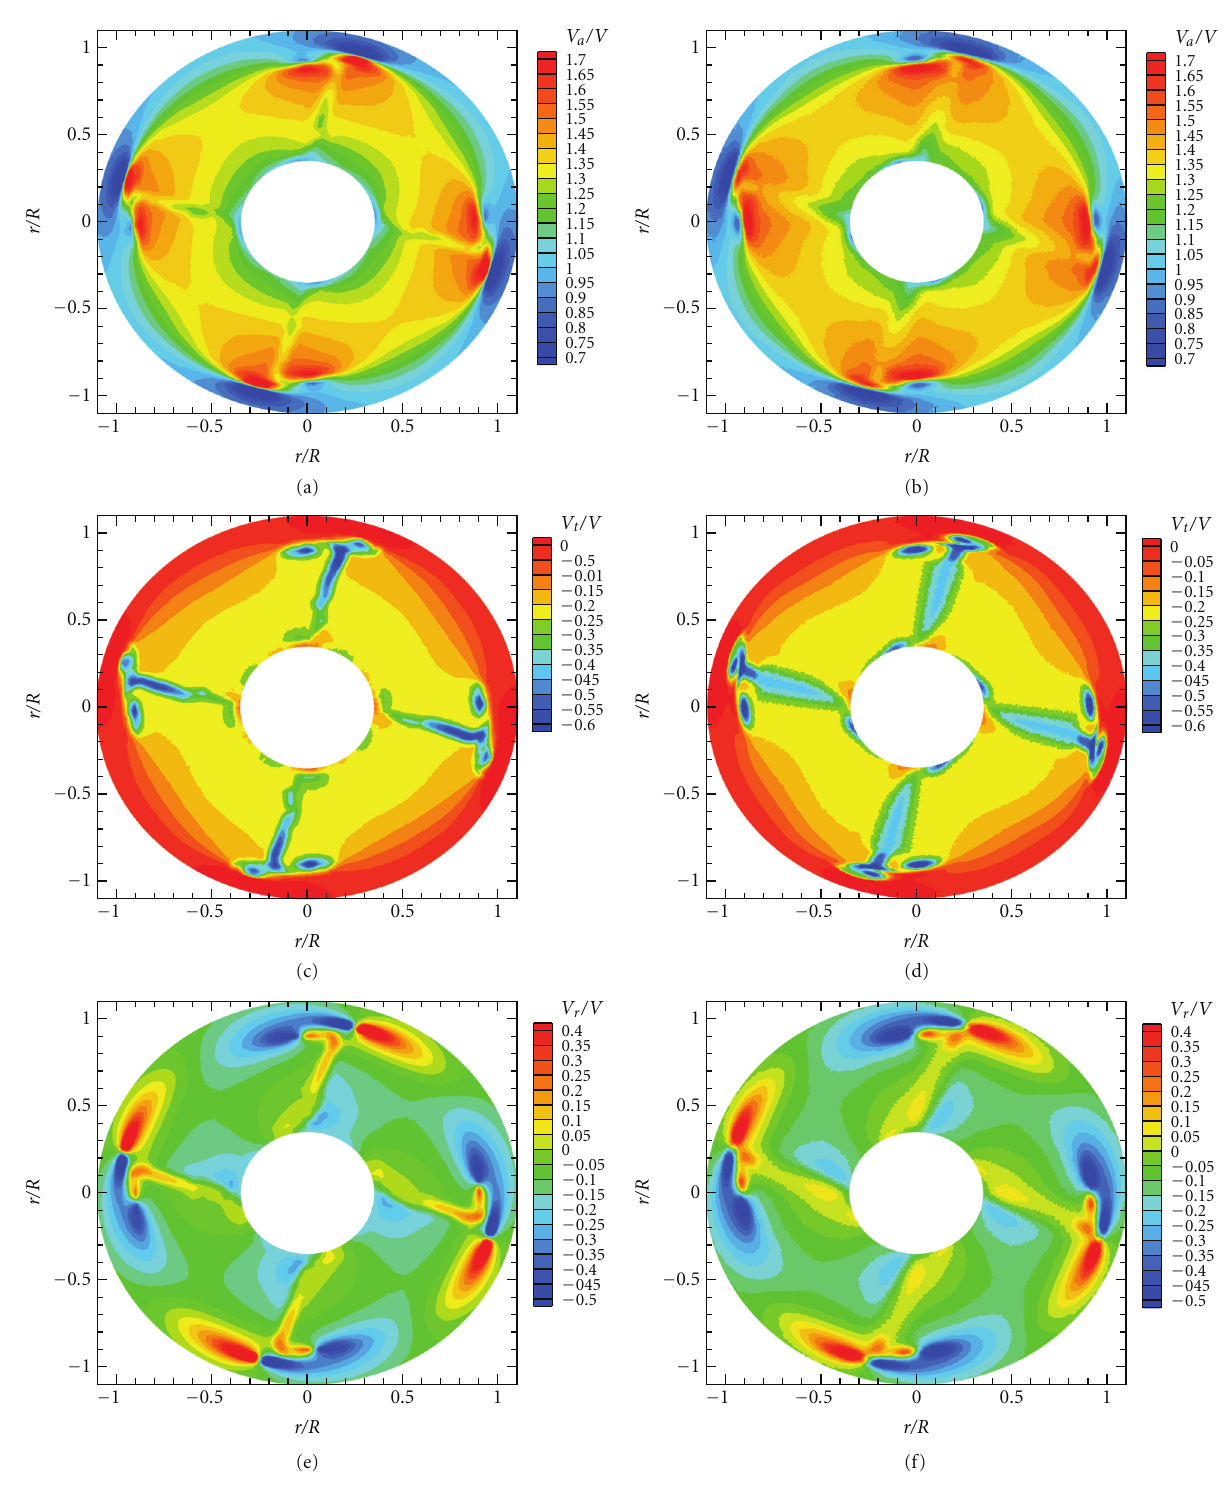
Figure 14: Axial, tangential, and radial nondimensional velocity distributions at x/R = 0.4875 aft the propeller plane. ((a), (c), and (e)) Experimental LDV measurements. ((b), (d), and (f)) RANSE computations on the finer